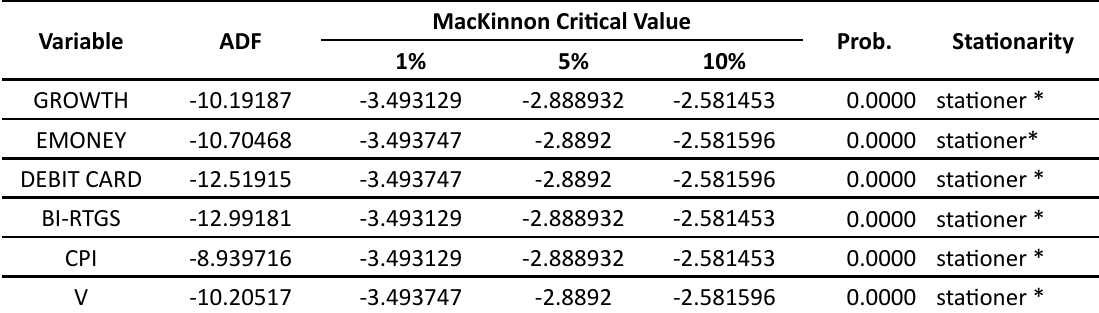
Table 2: First Difference Levels of Dickey-Fuller Stationarity Test Results